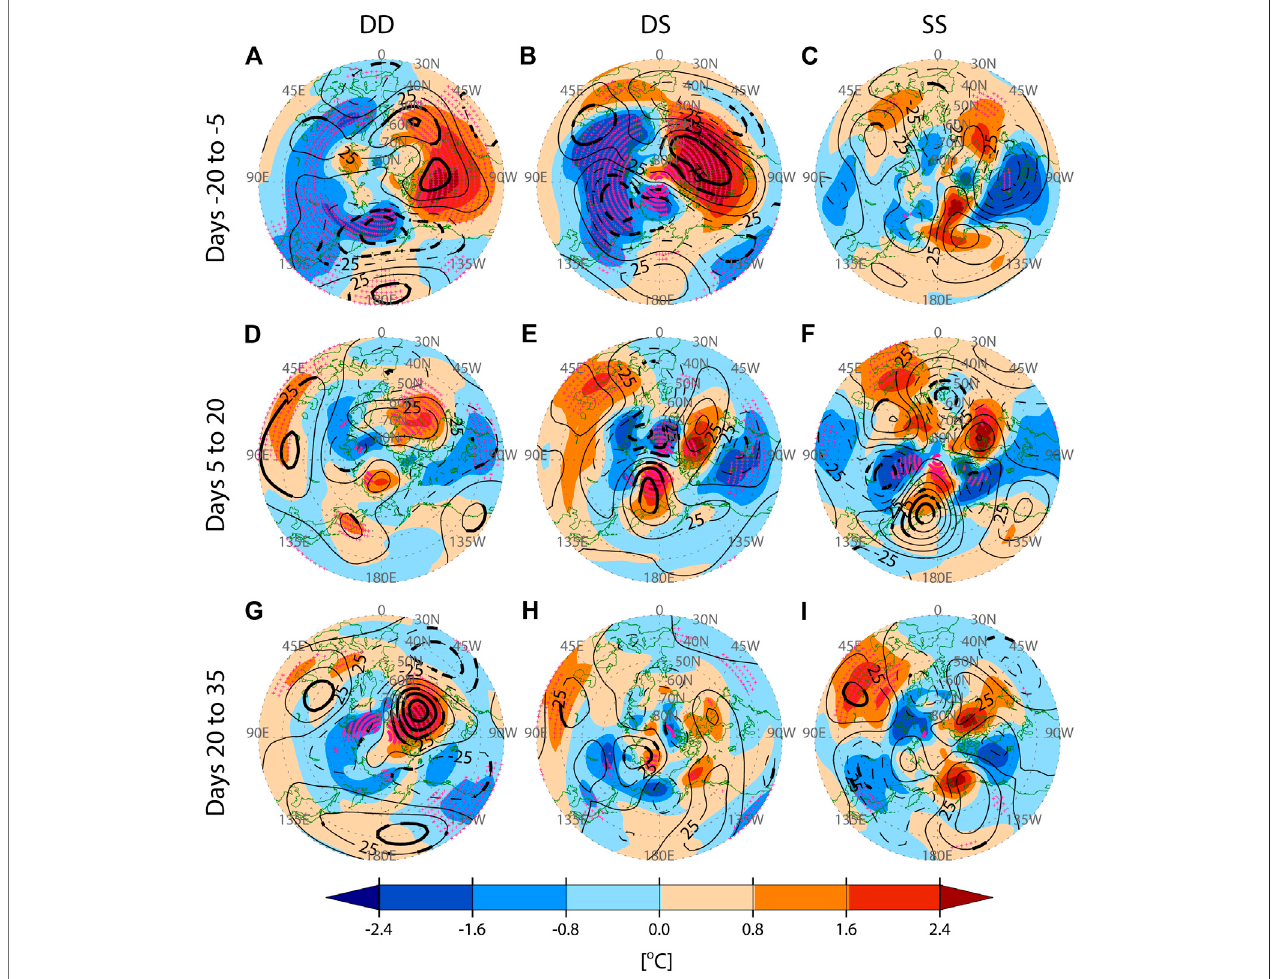
FIGURE 1 | Temperature anomaly at 1,000 hPa (shading) and geopotential height (GPH) anomaly at 300 hPa (contours) for zonal wave components from 1 to 5. The results are shown for (A,D,G) Displacement – displacement (DD); (B,E,H) Displacement – split (DS); and (C,F,I) Split – split (SS) sudden stratospheric warming (SSW) events, averaged (Top) from days -20 to -5, (middle) from days 5 to 20, and (bottom) from days 20 to 35. Contour interval is 25 m. Sold and dashed contours denote positive and negative values, respectively. Pink dots and bold contours indicate signi fi cant regions at 90% con fi dence level in temperature anomaly and GPH anomaly,